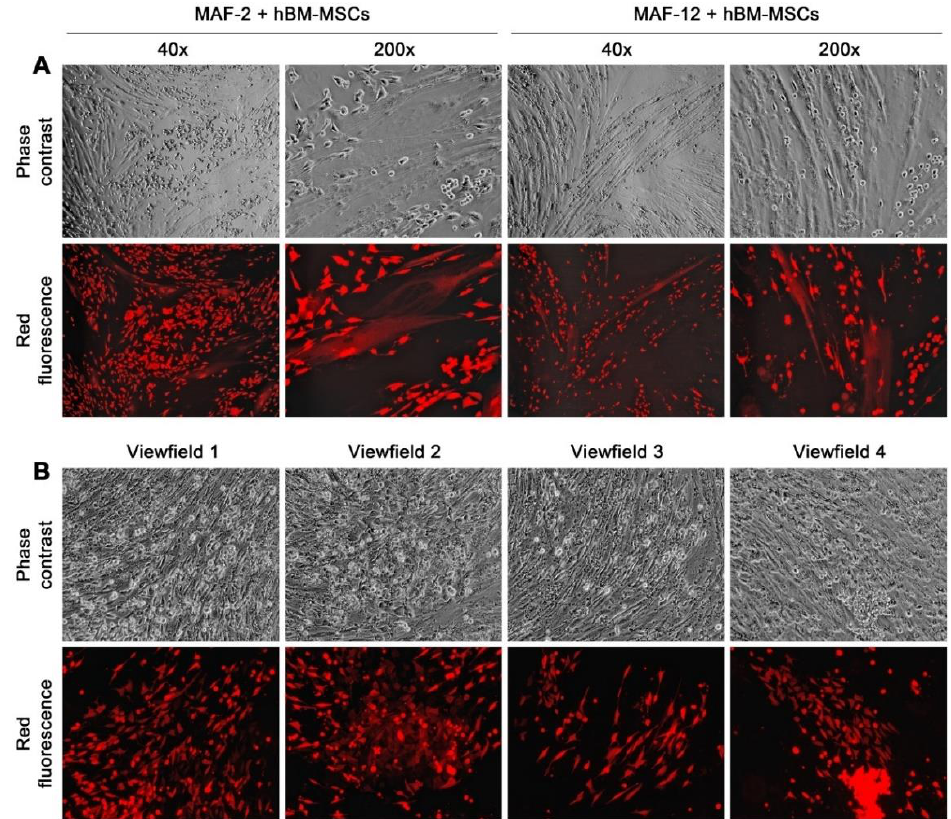
Figure 5. Second round co-culture with hBM-MSCs restored MAF-2 and MAF-12 cells to an altered attachment growth behavior. ( A ) After co-culture with hBM-MSCs for 14 days, many MAF-2 and MAF-12 cells adapted attachment growth. Some were involved in fusion with cells of the hBM-MSC monolayer, seen as large hBM-MSCs with red fluorescence, which is easier to identify at 200× mag- nification. ( B ) Images of four low-magnification (40×) view fields show that, as the co-cultures pro- ceeded beyond 3 weeks, many red fluorescent clones could be seen in the hBM-MSC monolayer, with individual clones displaying distinct cell morphology and growth behavior.